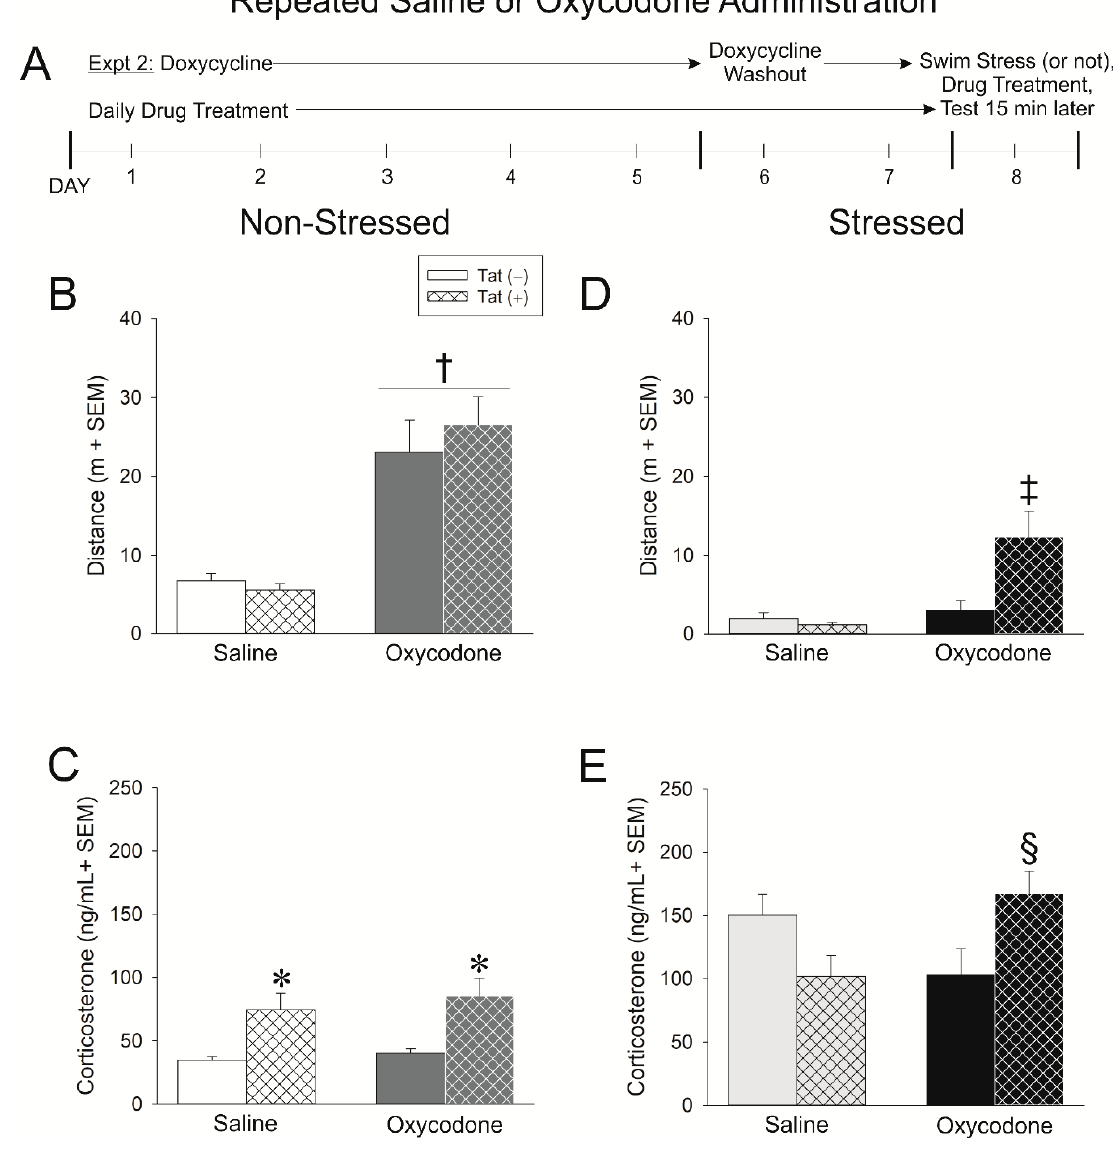
Figure 2. ( A ) In experiment 2, Tat( − ) (see open bars) and Tat( + ) (see hatched bars) mice were administered saline or oxycodone (3 mg/kg, i.p., once daily for 7 days) concurrent with the induction of HIV-1 Tat via doxycycline (30 mg/kg, i.p., once daily for 5 days with 2 days of doxycycline washout). Mice were stressed via forced swim for 15 min (panels ( D , E )) or not (panels ( B , C )), were administered the last treatment of repeated saline or oxycodone, and 15 min later were assessed in an open field and light dark transition test ( n = 8–10 / group). ( B ) Distance (m) traveled in an open field and ( C ) circulating corticosterone in among non-stressed mice. ( D ) Distance (m) traveled in an open field and ( E ) circulating corticosterone among stressed mice. * indicates a main e ff ect of genotype wherein Tat( + ) mice di ff er from Tat( − ) controls. † indicates a main e ff ect for oxycodone to di ff er from saline-administered mice. ‡ indicates an interaction wherein oxycodone-administered Tat( + ) mice di ff er from all other mice. § indicates an interaction wherein oxycodone-administered Tat( + ) mice di ff er from their respective Tat( − ) controls & Tat( + ) saline-administered mice, p < 0.05.